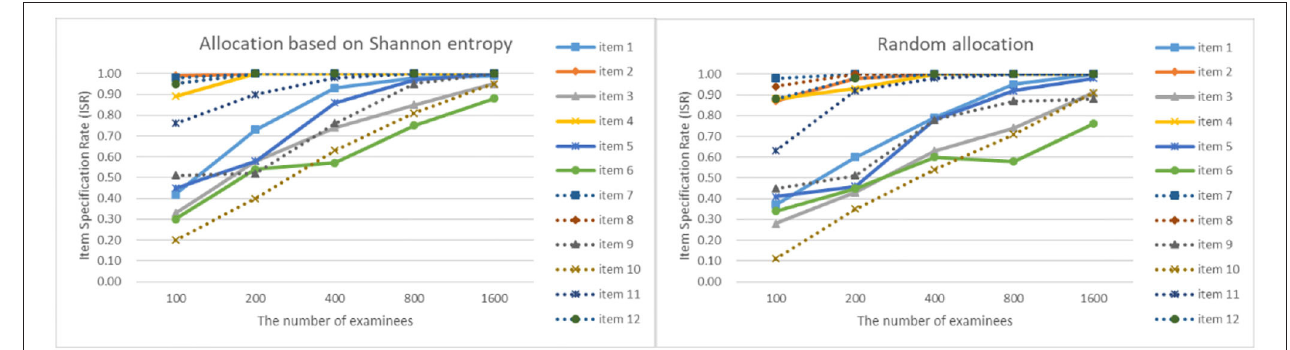
FIGURE 7 | The ISR for two strategies when the initial value of the item parameter is